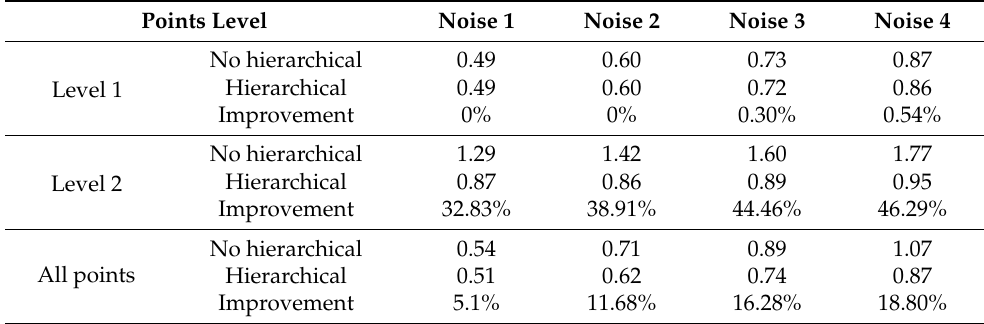
Table 3. Comparison of RMSE under four noise